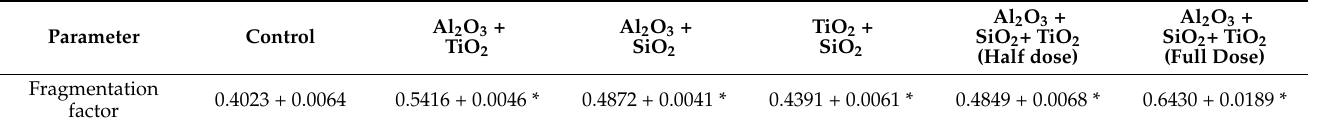
Table 4. An increase in the genomic DNA fragmentation factor of nucleated blood cells in rats following 18 intraperitoneal injections (during 6 weeks) of suspensions of various binary and ternary combinations of the MeO NPs as established AFLP assay (X ± Sx).